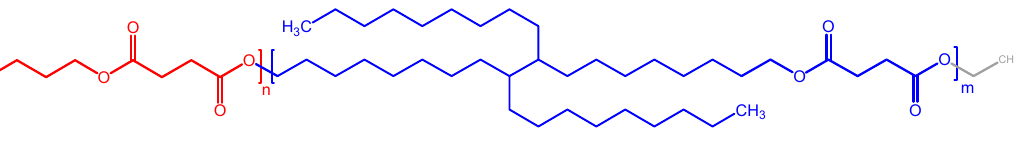
Figure 1. Chemical structure of synthesized PBS-DLS copolymers showing the composition of hard segments (red) and soft segments (blue).